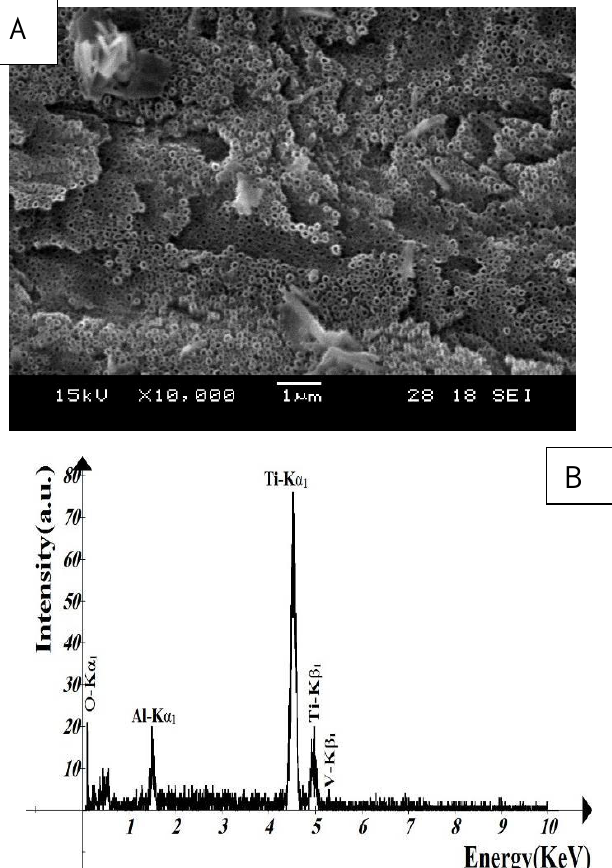
Figure 3. For anodized Ti-6Al-4V. A-SEM image. B- EDS